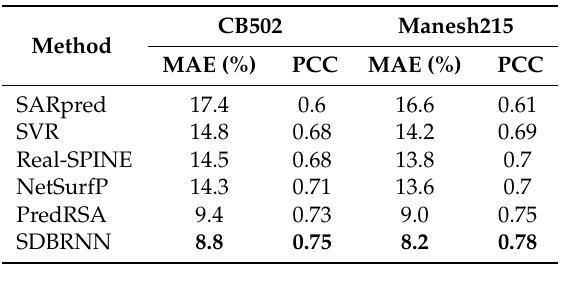
Table 2. Performance comparison in predicting relative solvent-accessible areas (the best results are shown in bold).